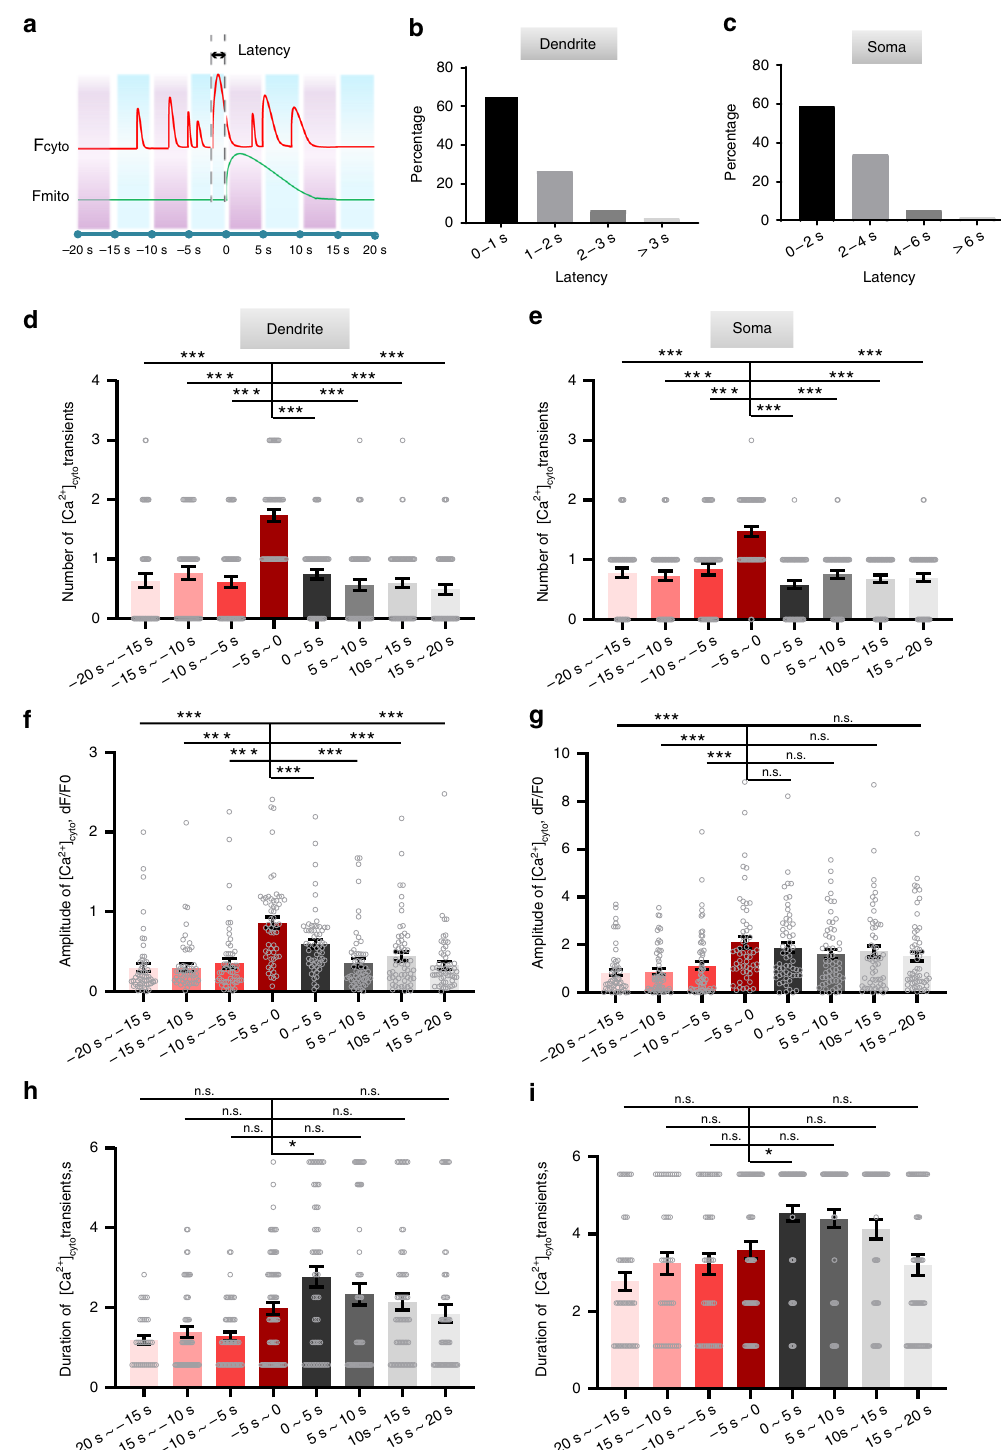
Fig. 5 Temporal analysis of [Ca 2 + ] mito and [Ca 2 + ] cyto coupling. a Schematic of eight selected time windows centered on the onset of [Ca 2 + ] mito transient. Latency: the delay of the onset of a coupled [Ca 2 + ] mito -to-[Ca 2 + ] cyto event. b , c Statistics of the coupling latency in dendrites ( b , n = 48 events) and somas ( c , n = 49 events). d – i Distribution of the number ( d , e ), peak amplitude ( f , g ), and duration of [Ca 2 + ] cyto transients ( h , i ) over different time windows in dendrites ( d , f , h , n = 42 – 60 dendrites from 6 mice) and somas ( e , f , i , n = 40 – 60 somas from 7 mice). Data are presented as mean ± SEM. *P < 0.05.